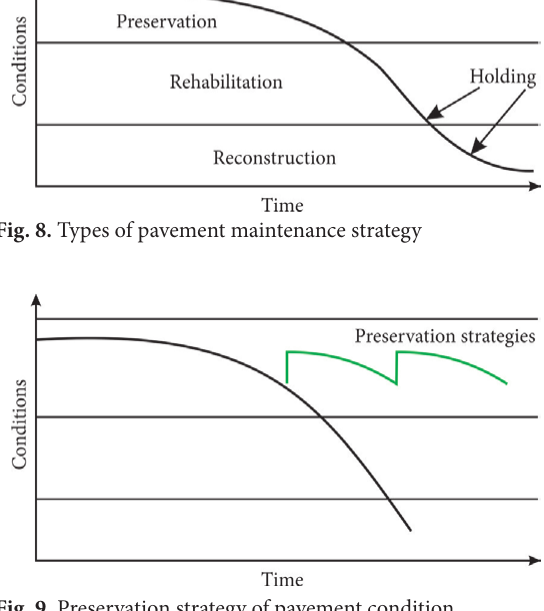
Fig. 9. Preservation strategy of pavement condition